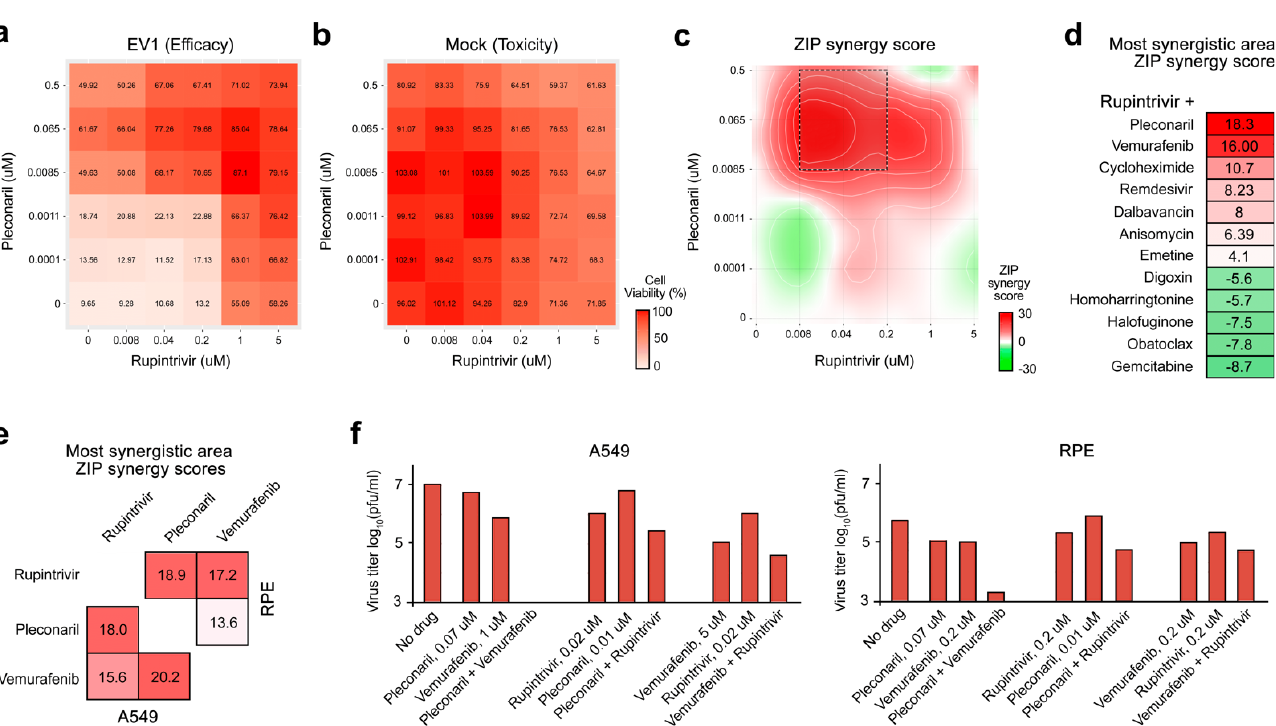
Figure 2. Anti-EV1 activity of BSA-containing combinations (BCCs). ( a ) The interaction landscape of the rupintrivir–pleconaril combination was measured using the CellTiter-Glo (CTG) assay on EV1-infected cells. ( b ) The interaction landscape of the rupintrivir–pleconaril combination measured using the CTG assay on mock-infected cells. ( c ) Synergy interaction landscape for selectivity (Selectivity=Efficacy-(100-Toxicity)) of the drug combination. ( d ) ZIP synergy scores calculated for the most synergistic areas (MSA) of interaction landscapes for selectivity obtained for rupintrivir-containing drug combinations on A549 cells. ( e ) Heatmap showing ZIP synergy scores calculated for the most synergistic areas (MSA) of interaction landscapes for selectivity obtained for 3 BSA combinations on A549 and RPE cells. ( f ) The effects of different concentrations of rupintrivir, pleconaril, vemurafenib and their combinations on replication of EV1 in A549 and RPE cells measured by plaque reduction assay.